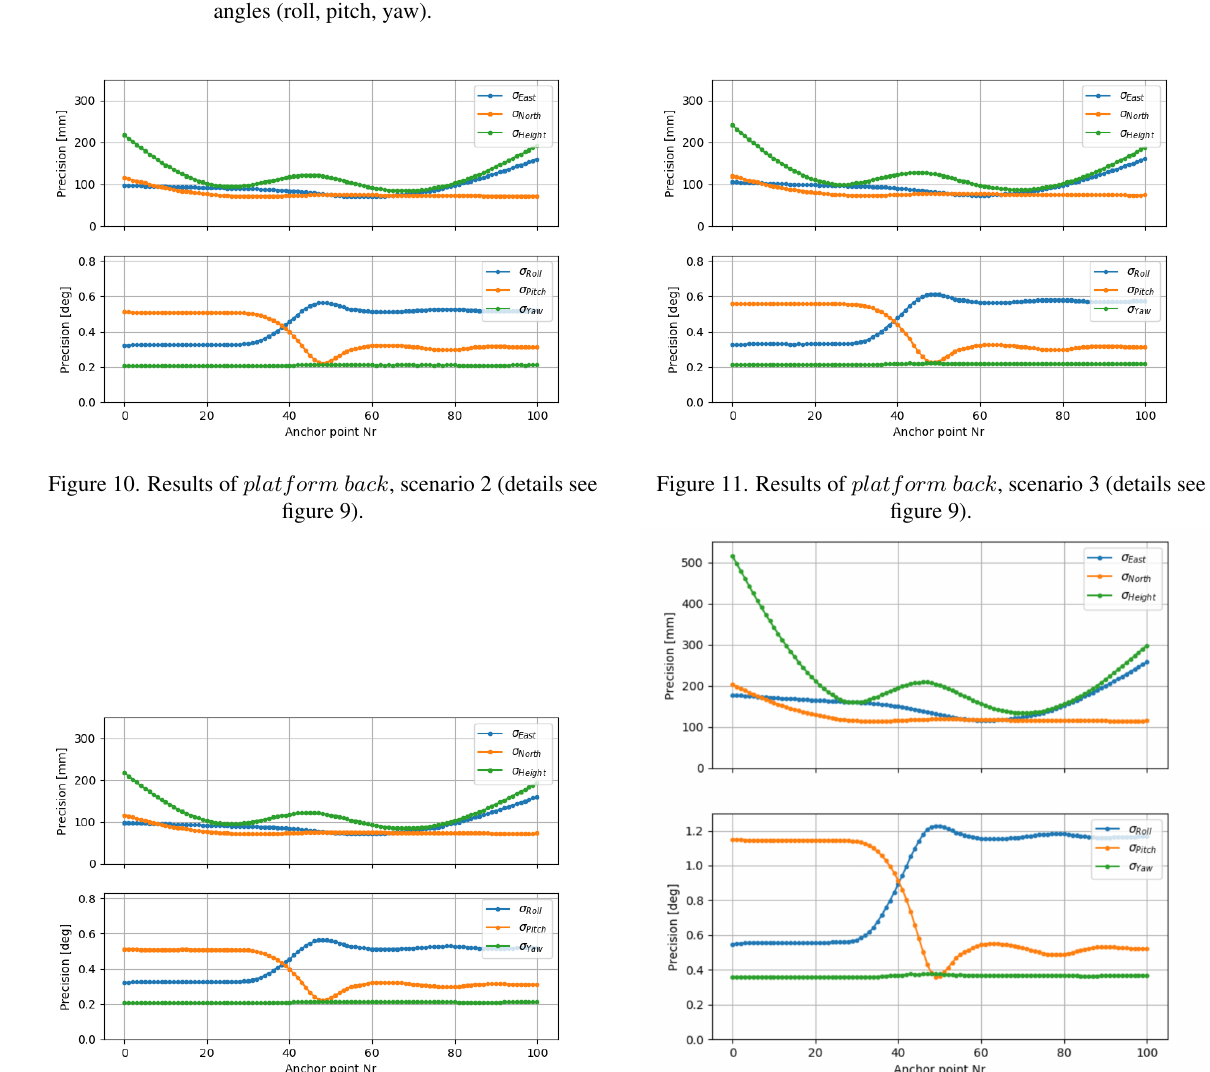
Figure 12. Results of platform back , scenario 4 (details see figure 9).